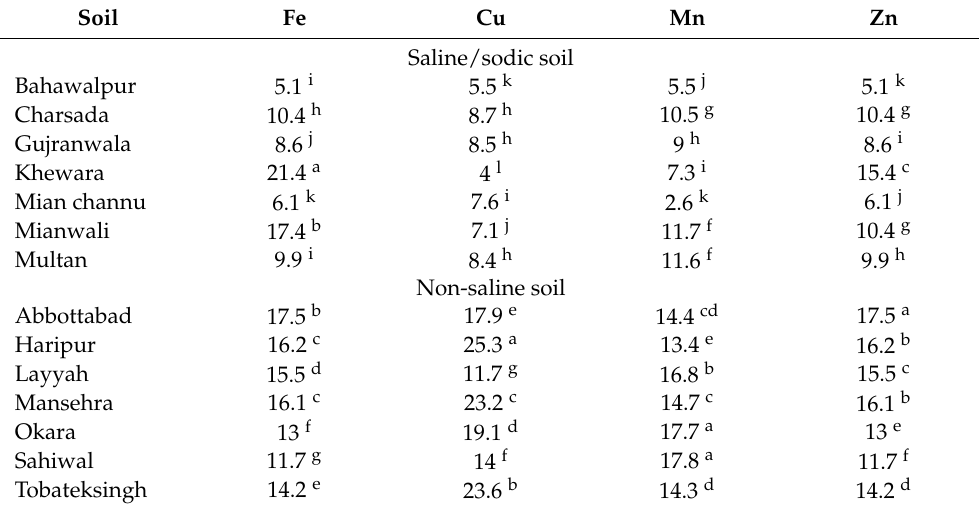
Table 7. Mobility factor (%) of micronutrients under saline and non-saline conditions.